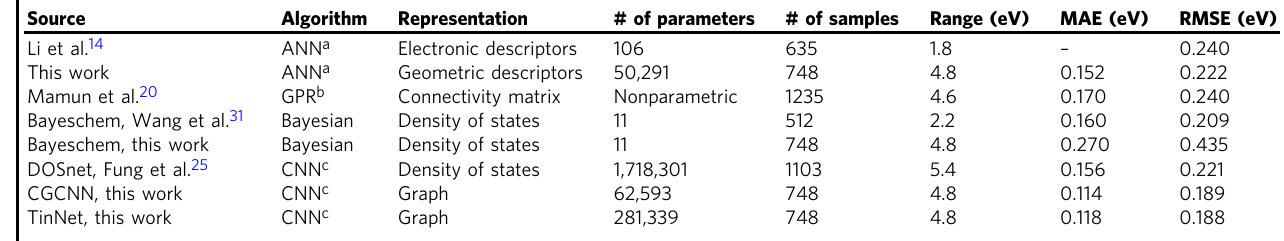
Table 1 Benchmark comparison of ML models of *OH chemisorption on alloy